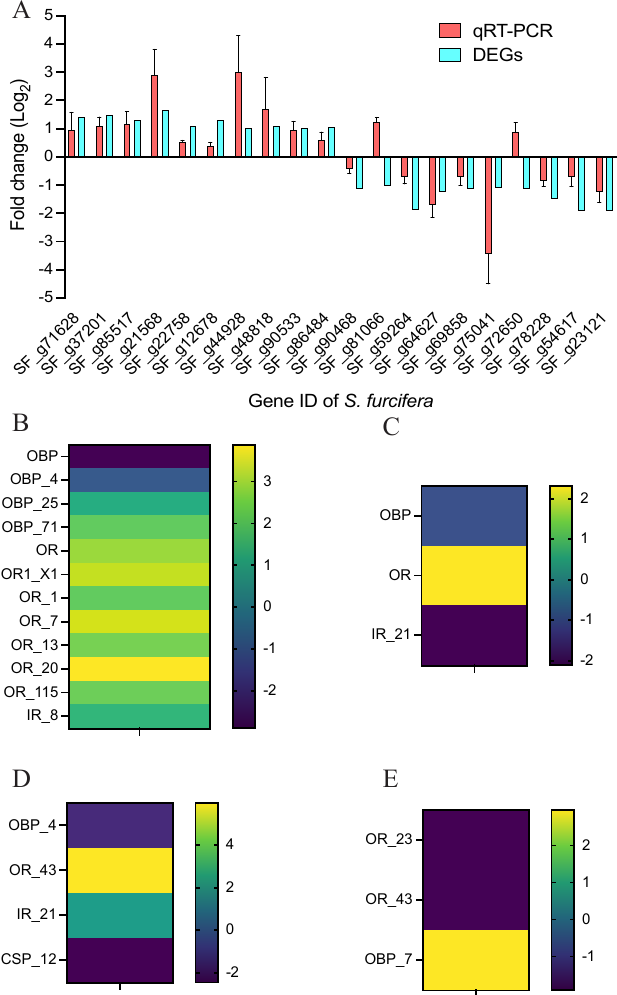
Figure 5. Transcriptomic validation by qPCR and the olfactory-related genes identification. ( A )